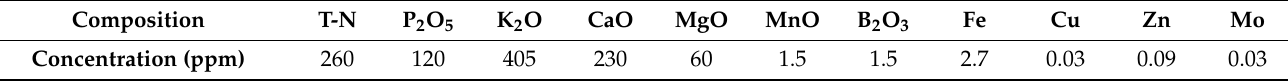
Figure 2. The hydroponic system used in this study. ( a ) Diagram of up view; ( b ) photograph; the cultivation container dimensions were 620 mm length (L) × 375 mm width (W) × 195 mm height (H). The flow inlet and flow outlet were located at the center of the sidewall, and the flow inlet and outlet diameters were both 18 mm.